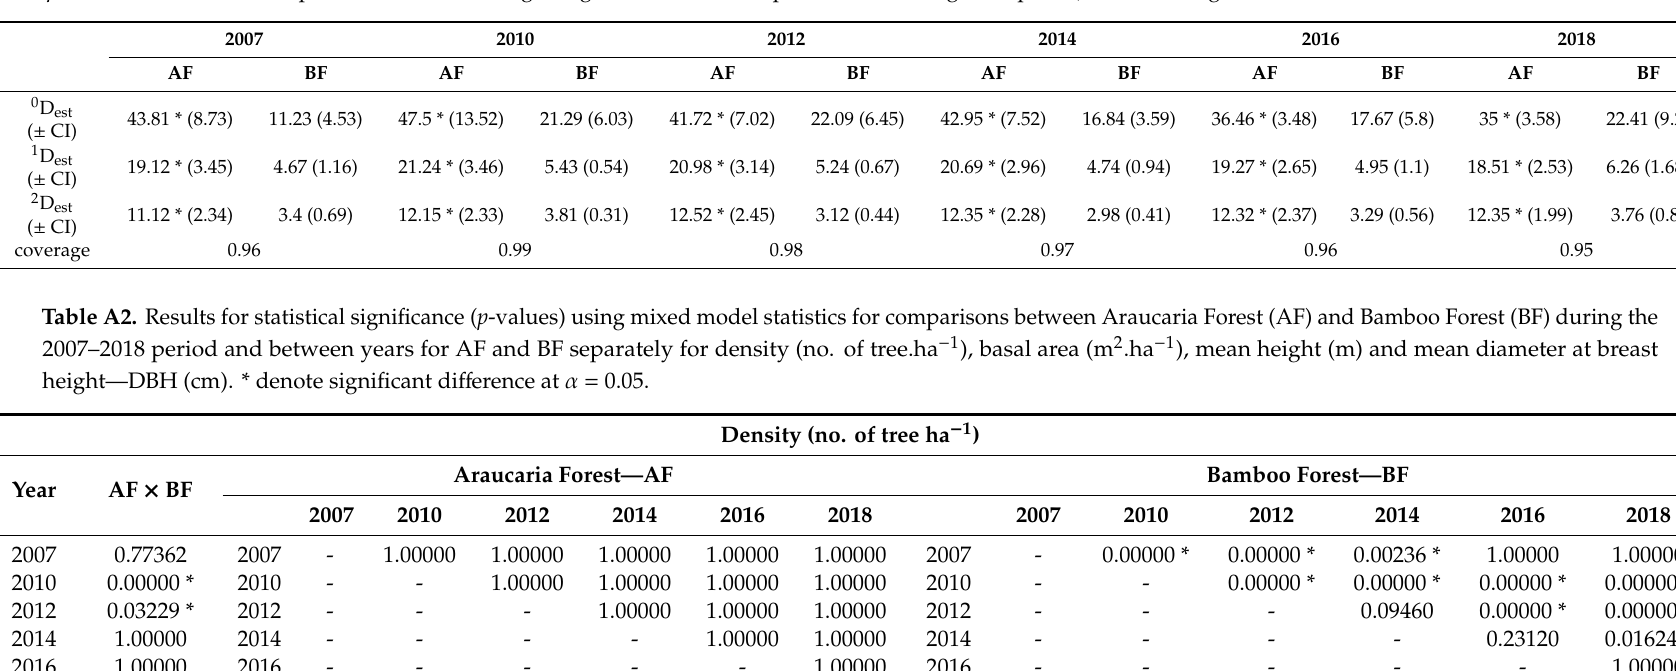
Table A1. Yearly comparison of estimated Hill numbers ( q D est ; q = 0 to 2) between Araucaria and Bamboo Forest, compared at a common percentage of sample coverage with 95% confidence intervals ( ± CI) and overall coverage. ( q = 0 is richness; q = 1 effective number of species where species are weighted in proportion to their frequencies; q = 2 effective number of species where more weight is given to abundant species, discounting rare species). * denotes significant difference at α = 0.05.